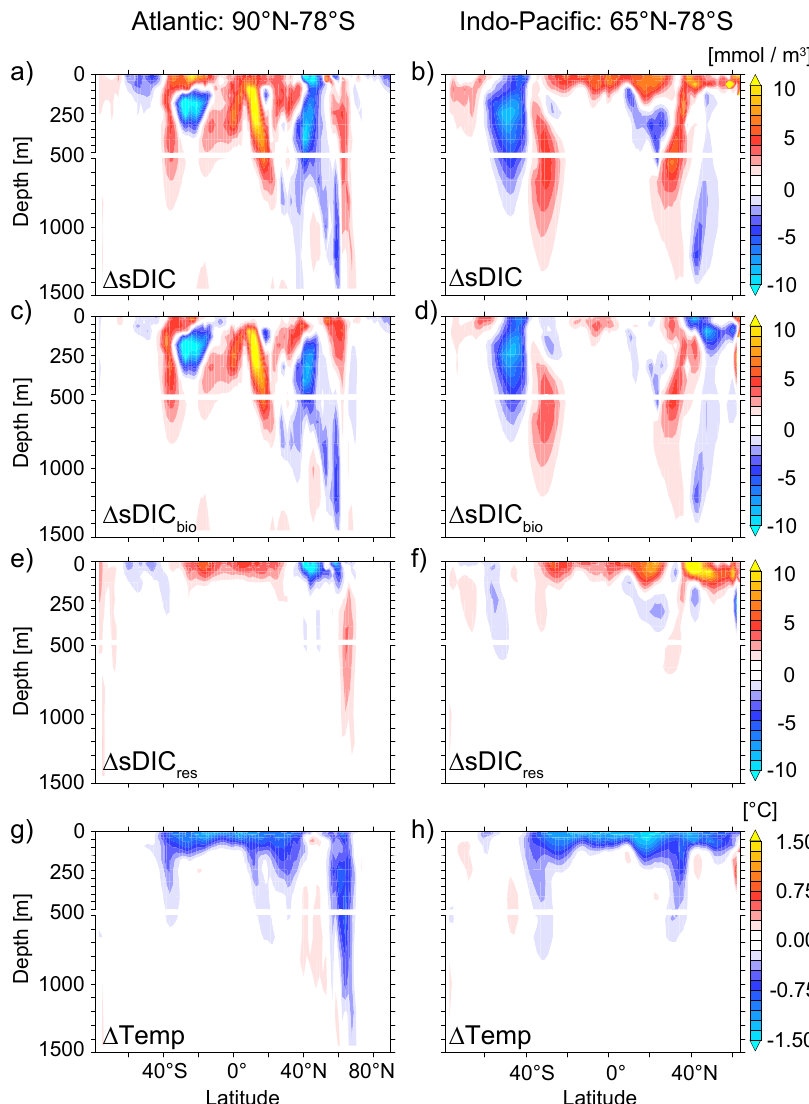
Fig. 10. Zonal mean differences between the Pin.10x case and the control simulation in the Atlantic Ocean (including the Arctic Ocean; a, c, e, g ) and the Indo-Pacific Ocean (b, d, f, h) : (a–b) s DIC, (c–d) s DIC changes due to the internal reorganization of the organic matter cycle and CaCO 3 cycle ( s DIC bio ), (e–f) the residual s DIC ( s DIC res = s DIC– 1s DIC bio ), and (g–h) potential temperature. All panels show results averaged over the first 5yr of the simulations. Changes in zonal mean s DIC are significant almost everywhere in the top 1500m (not shown).